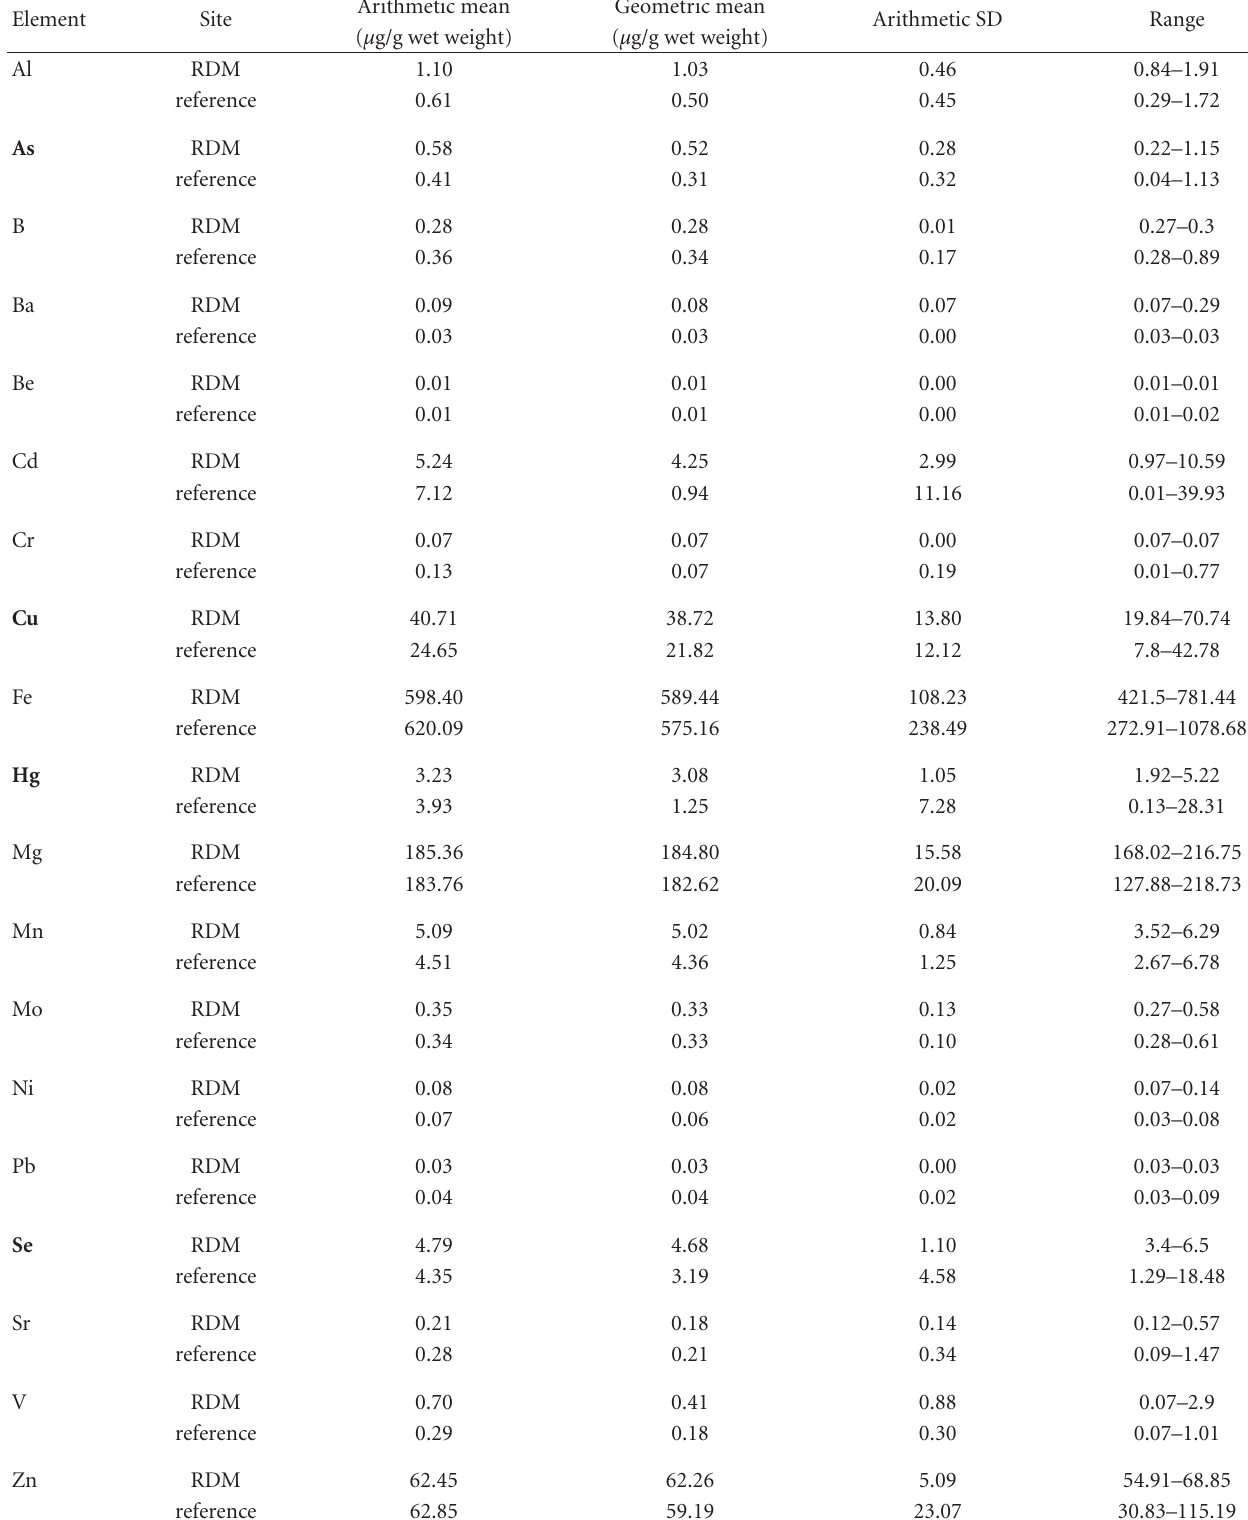
Table 1: Trace element concentrations ( μ g/g wet weight) in bearded seal liver samples from nine seals harvested near the Red Dog Mine port site (RDM) and 15 seals harvested near reference sites. Concentrations are summarized as arithmetic and geometric means, arithmetic standard deviations, and ranges. Detection limits are presented in Table 2. Elements in which concentrations were found to be significantly di ff erent between sites are in